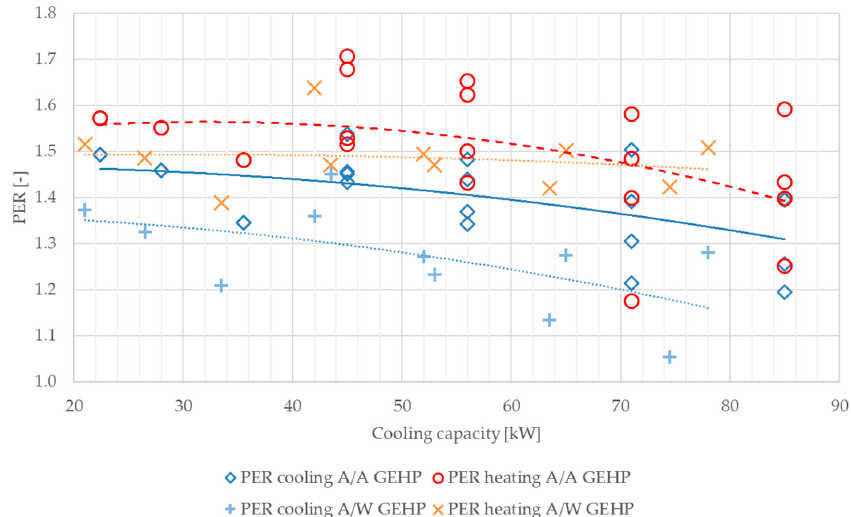
Figure 19. Comparison among PERs of air-to-water and air-to-air GEHP units. Some GEHP models include the ability to add a DHW (Domestic Hot Water) kit to exploit thermal recovery from the engine when GEHP works in cooling mode. In this case, the PER of the unit strongly increases, as shown in Figure 20, moving from 1.4 (cooling only) to 1.9 (combined heating and cooling) with an improvement of about 36%.